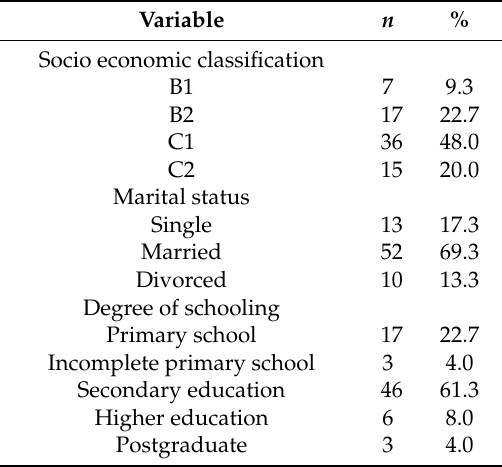
Table 1. Socioeconomic characterization of